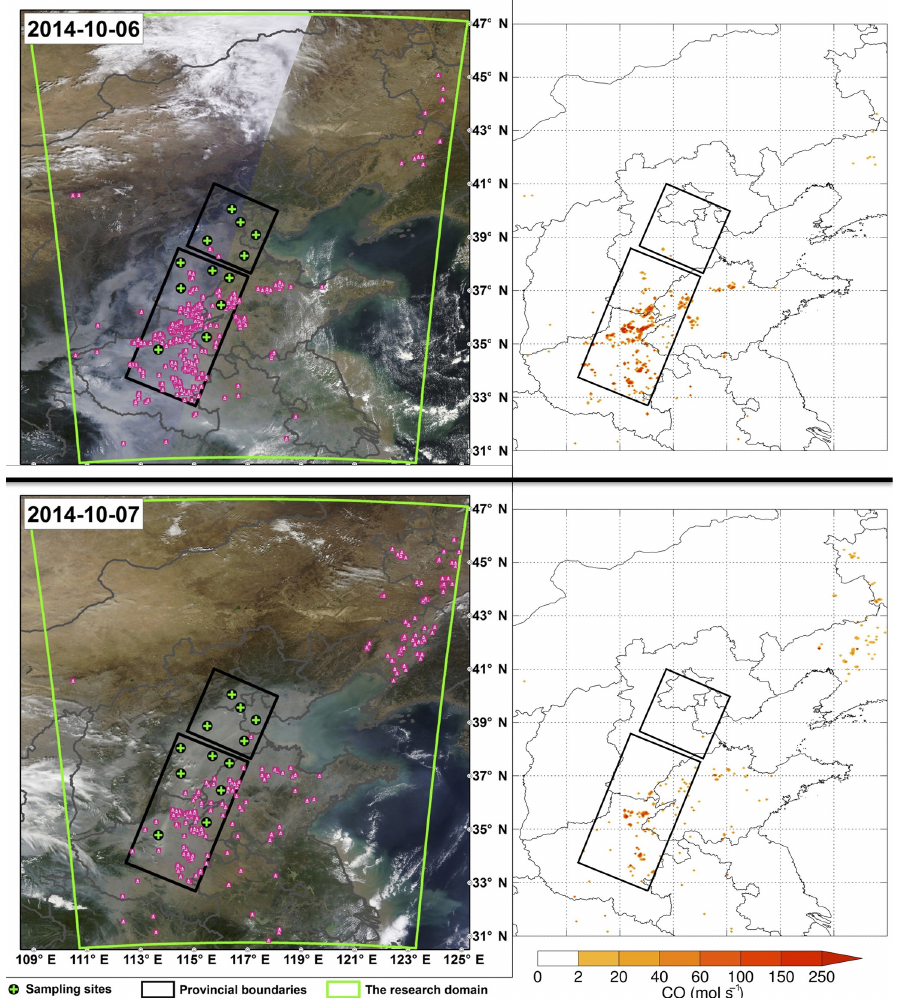
Figure 3. CFB captured by MODIS with the background of MODIS real-time true color map (left) and related CO emission (right) on 6 and 7 October.